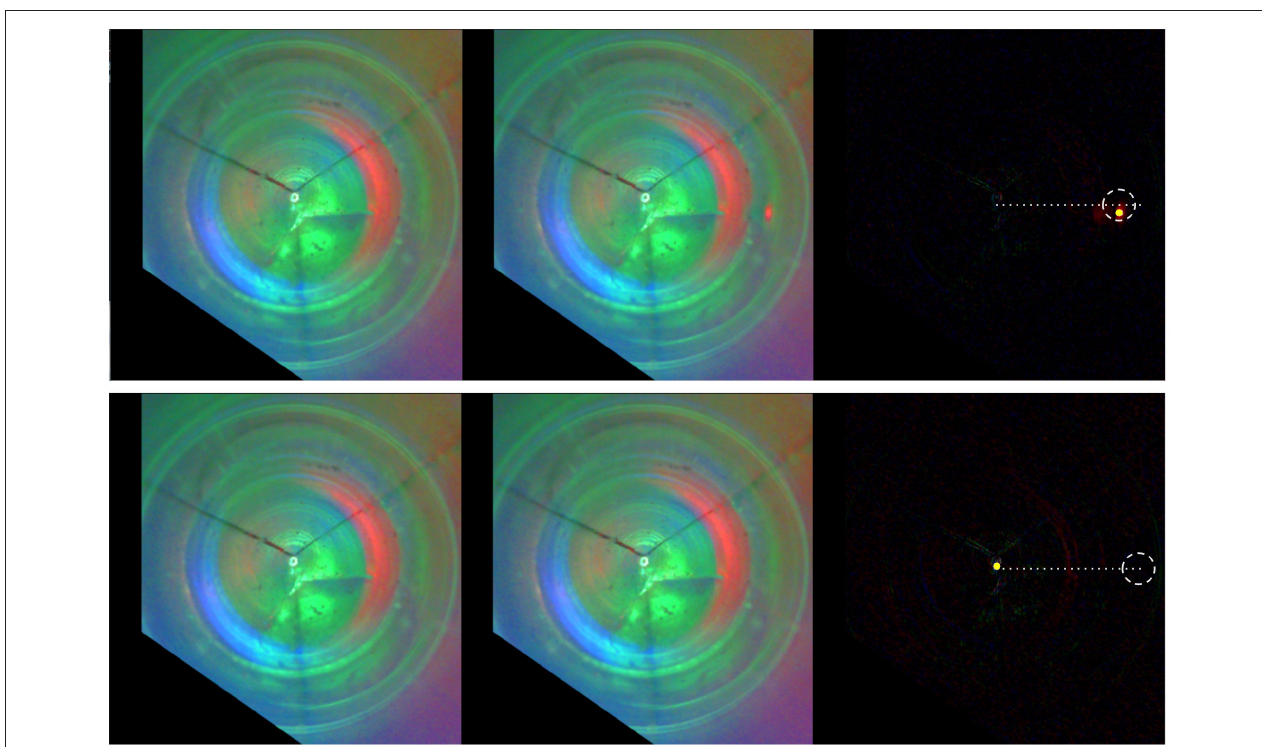
FIGURE 9 | Contact localization for the smallest and largest errors, that is, < Cone , θ = 0 > and < Slab , τ = 15 mm > . From left to right: the reference frame, the in-contact frame, the computed pixel-wise absolute difference. The contact region (dash circumference), the predicted contact position (yellow circle), and the axis where the contacts occur (dotted line) are highlighted in the right most frame.